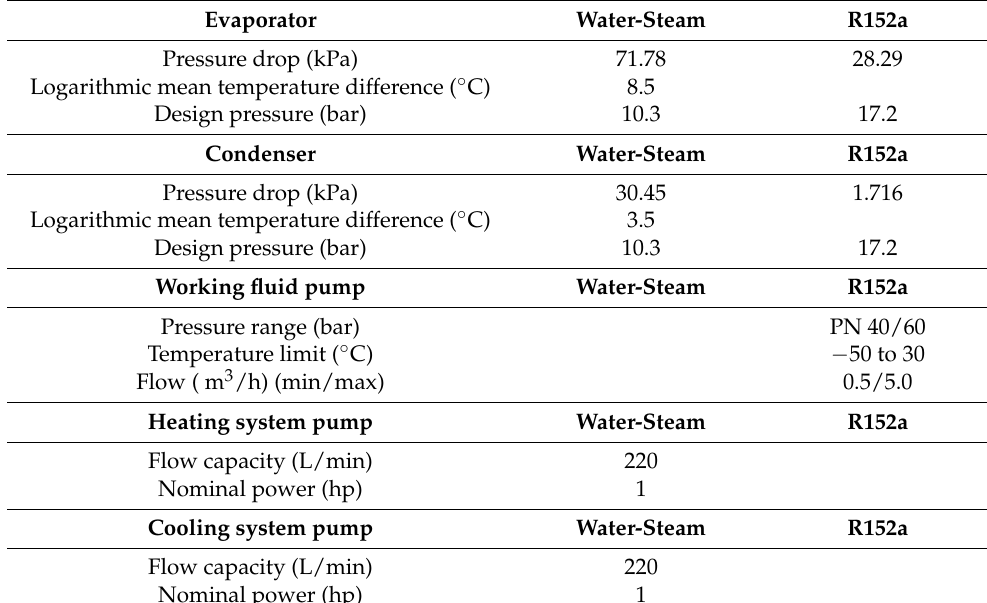
Figure 1. OTEC-CC-MX-1 kWe prototype general diagram. Table 1. OTEC-CC-MX-1 kWe prototype main components